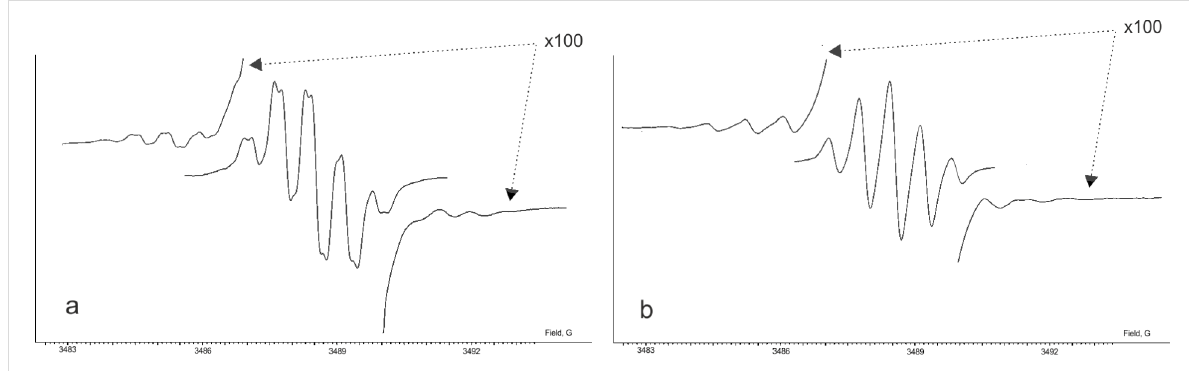
Figure 4: The EPR spectrum of (1 · − )H 2 THF, 293 K: a) experimental and b) experimental + D 2 O). Magnified side lines correspond to 33 S satellite components.